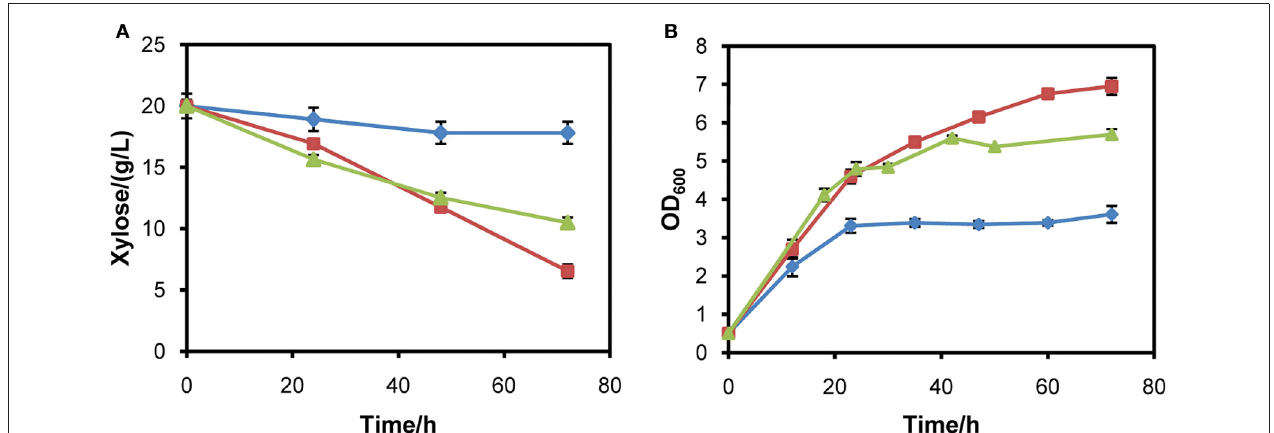
FIGURE 6 | Aerobic growth of strains W303a-C, W303a-I, and W303a-II in YPX medium. (A) Xylose consumption. (B) Growth profiles. Symbols: diamonds, W303a-C; squares, W303a-I; triangles, W303a-II. W303a-C is the W303a strain harboring a multicopy plasmid of pRS426. In contrast, W303a-I